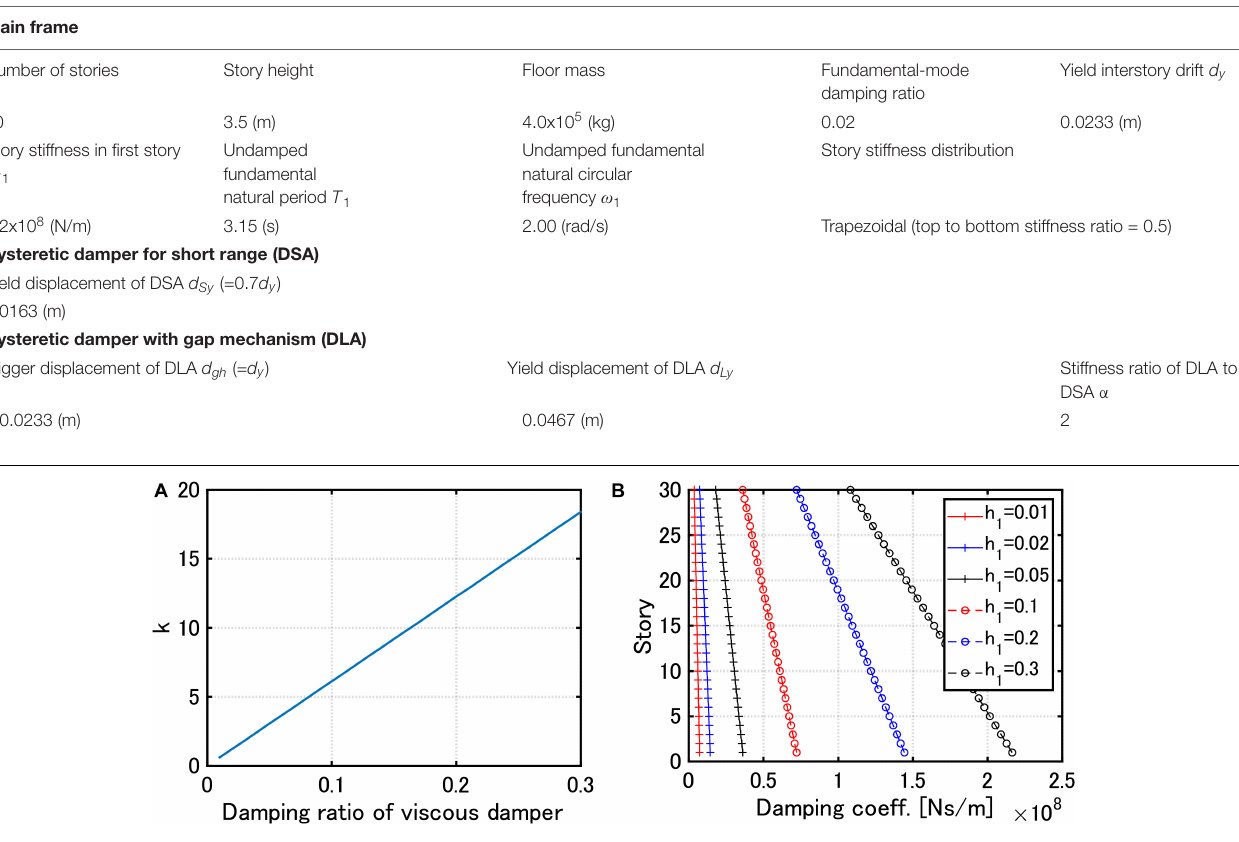
TABLE 2 | Structural parameters of main frame and two hysteretic dampers (DHD system).